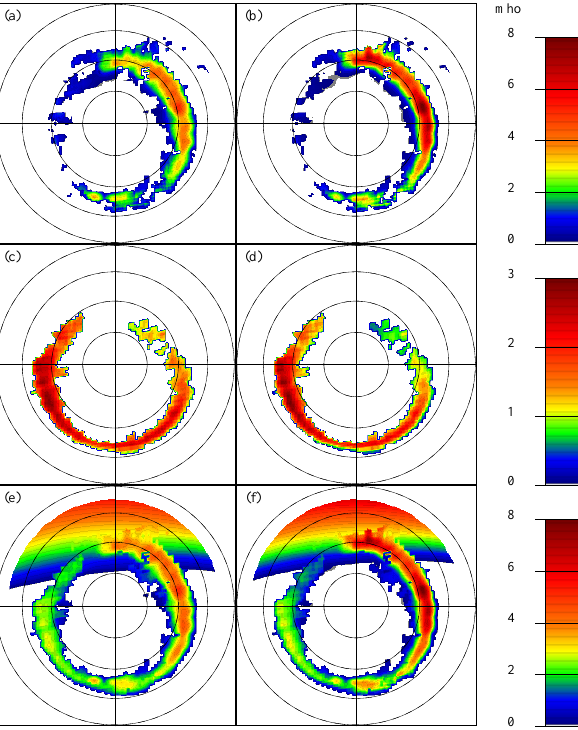
Plate 2. Idem Plate 1 for 23 December 2000, 21:04UT with K p =2. Circles show 50 ◦ , 60 ◦ , 70 ◦ and 80 ◦ MLAT. The local midnight is located